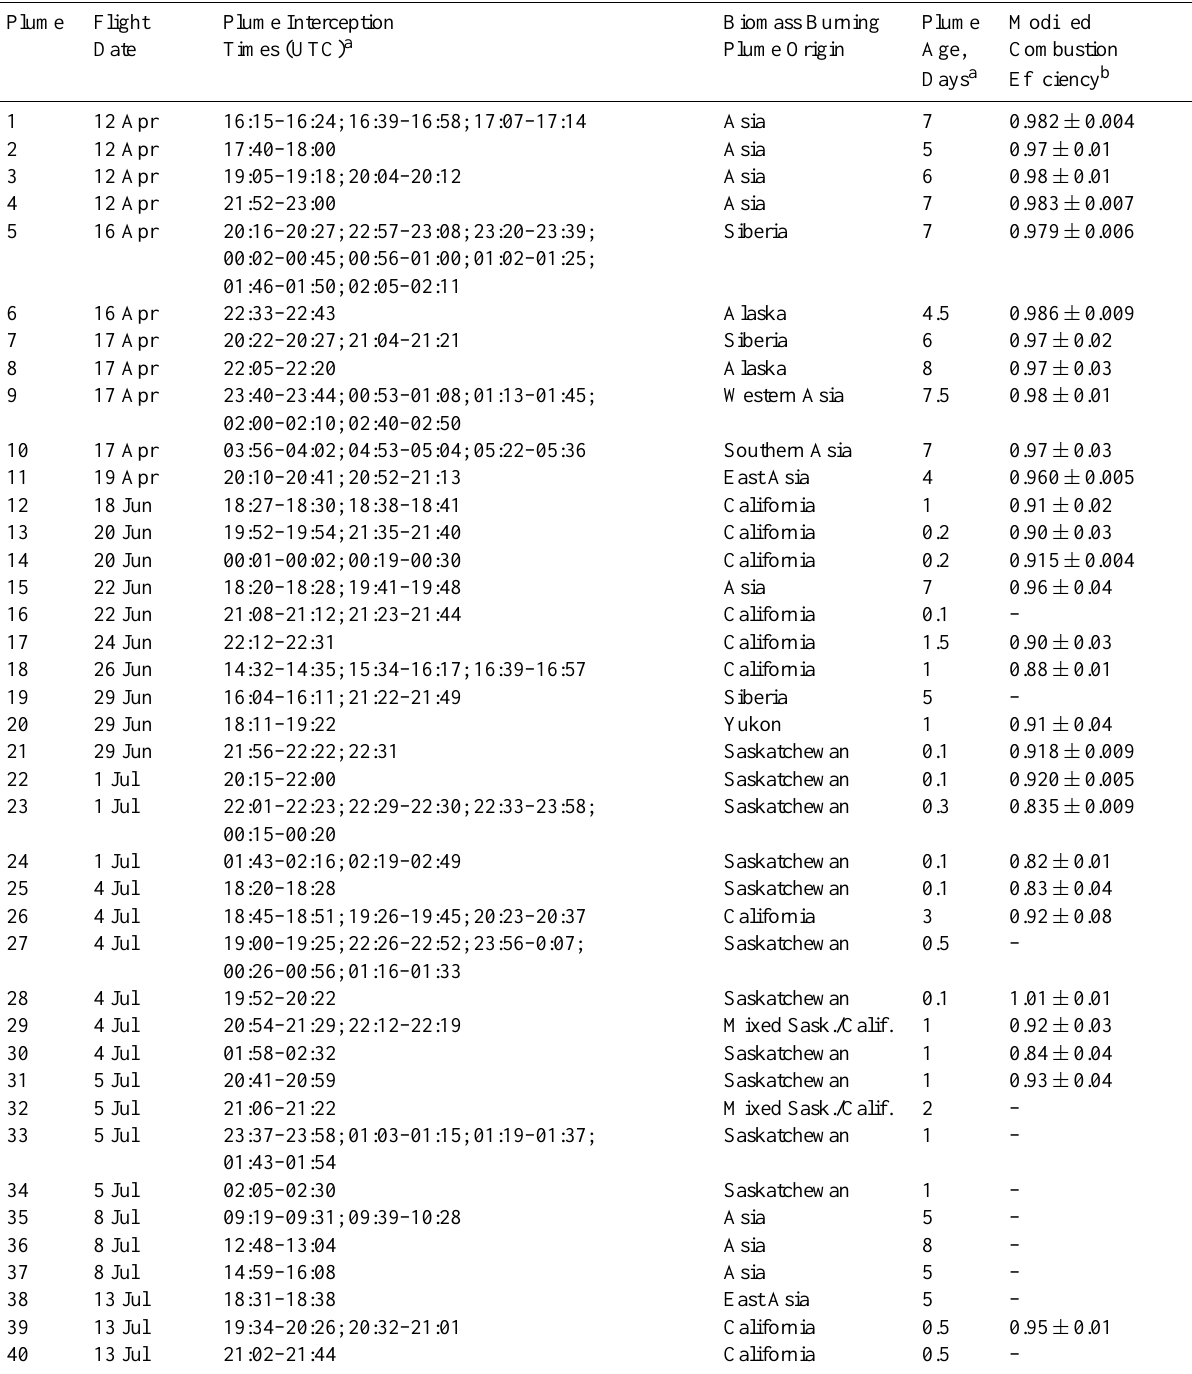
Table 1. Summary of Biomass Burning Plume